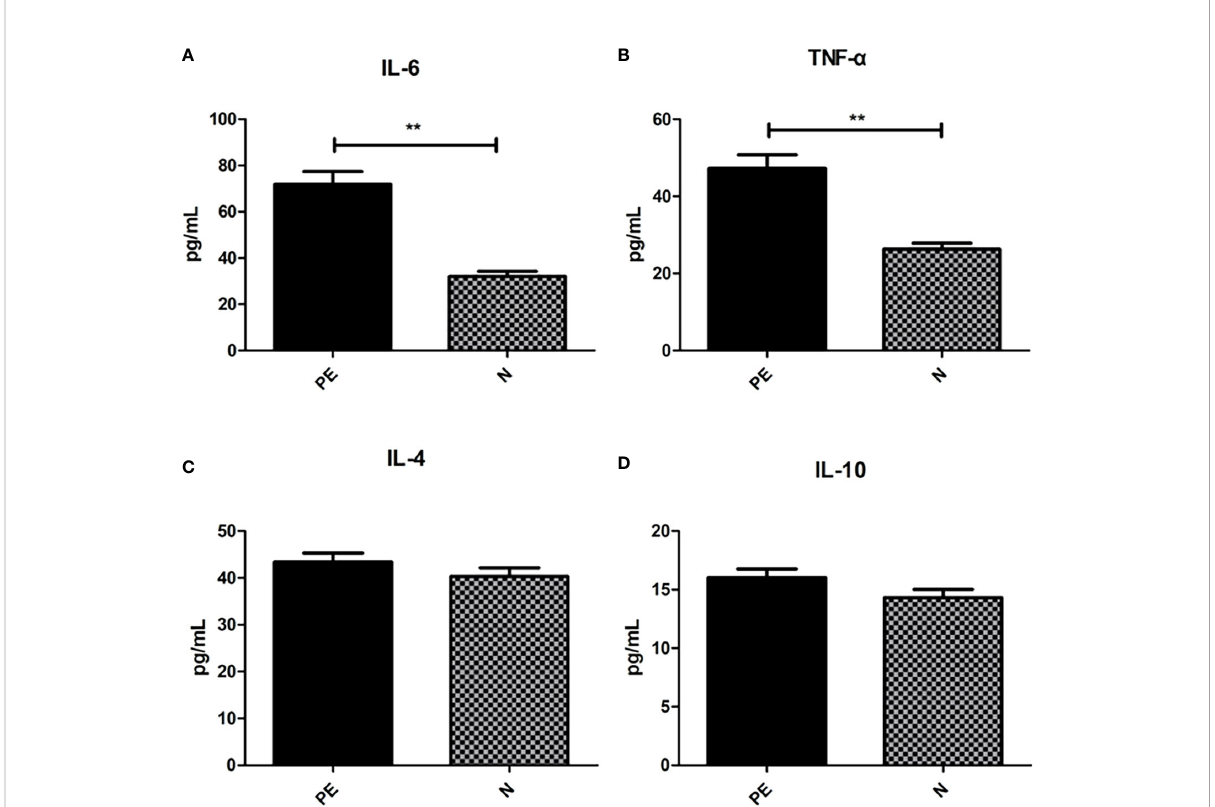
FIGURE 6 Varying in fl ammatory factors in the two groups. There were signi fi cant differences in the IL-6 (A) and TNF- a (B) between the two groups. However, no signi fi cant differences were observed in IL-6 (C) and IL-10 (D) between the two groups. PE, preeclampsia; N, the healthy normal group. ** P <